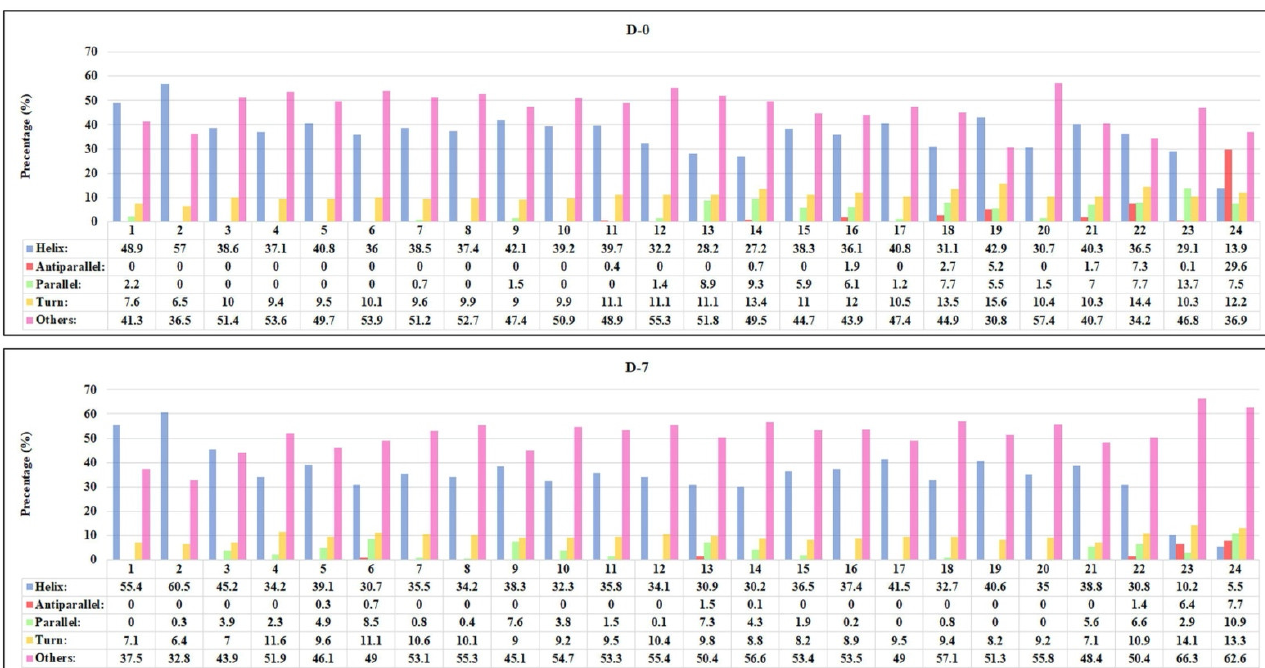
Figure 6. Percentage of secondary structures calculated using the BestSel program referred to D-0 and D-7: 1 (HSA 1 μM), 2 (gHSA 1 μM), 3 (gHSA-ASX 3 μM), 4 (HSA-ASX 3 μM), 5 (gHSA-ASX 20